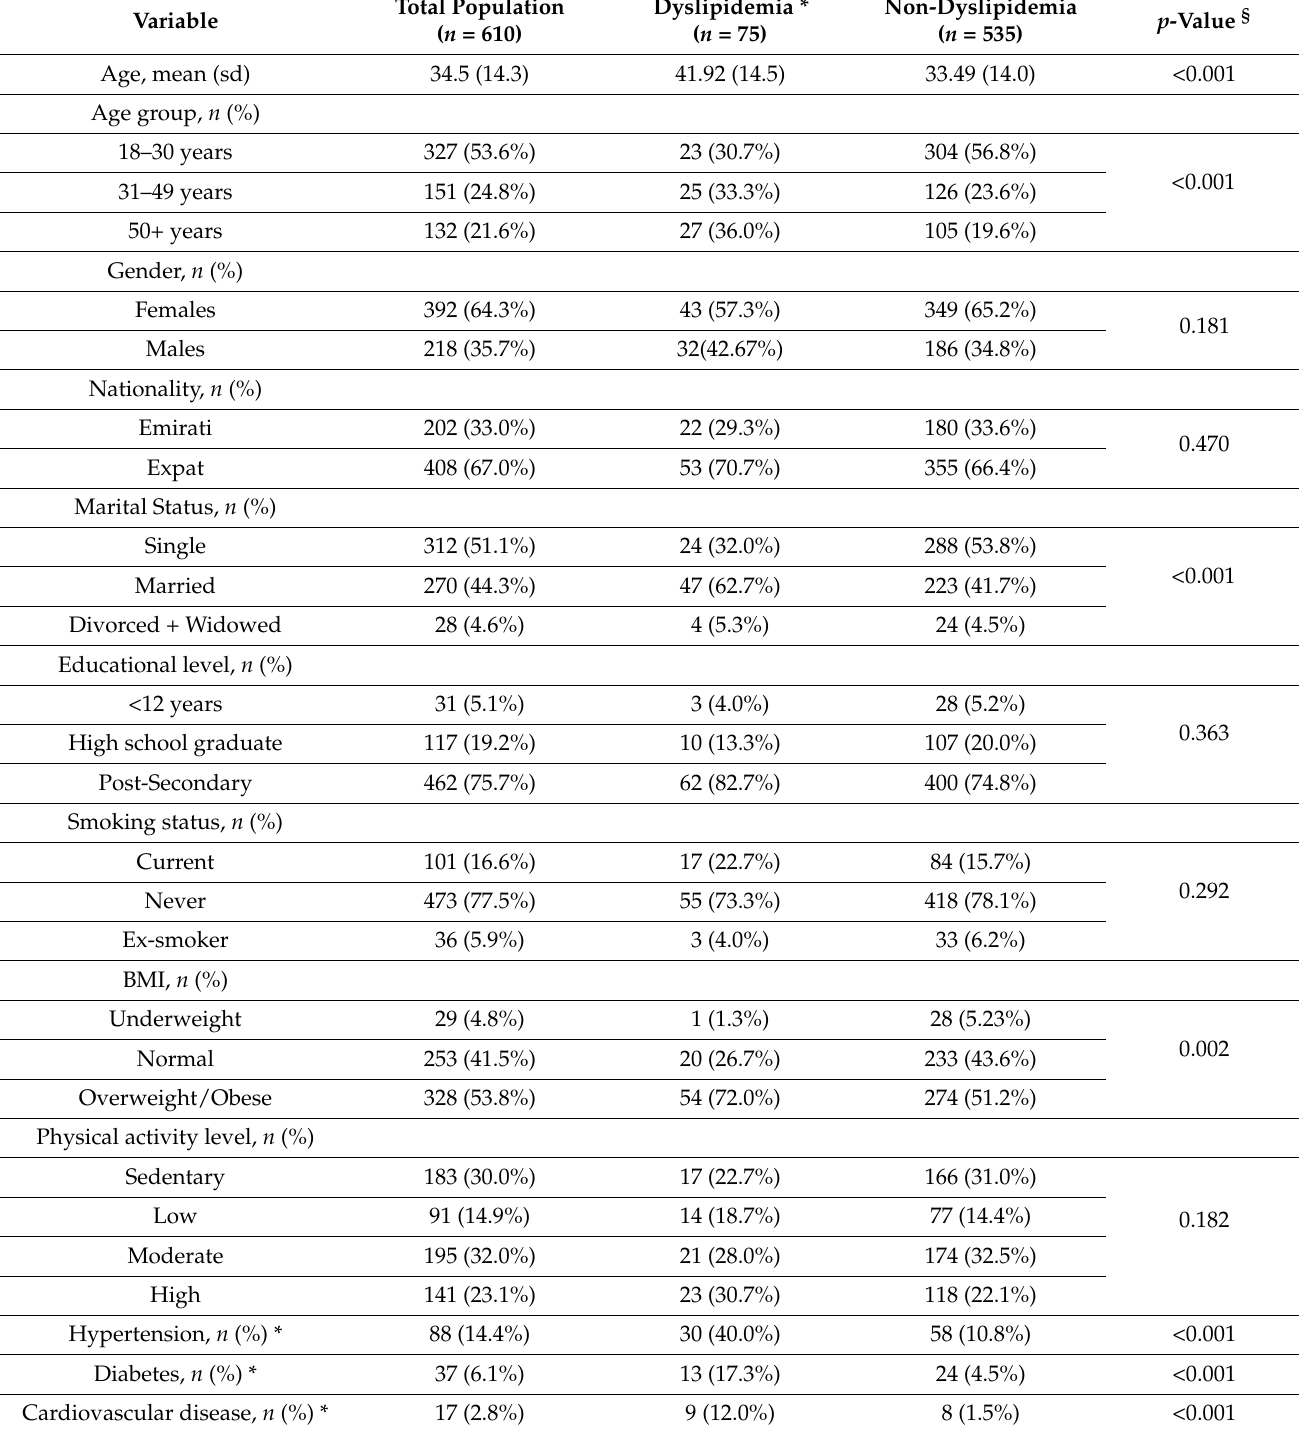
Table 1. Association of dyslipidemia with sociodemographic characteristics, BMI, physical activity and chronic